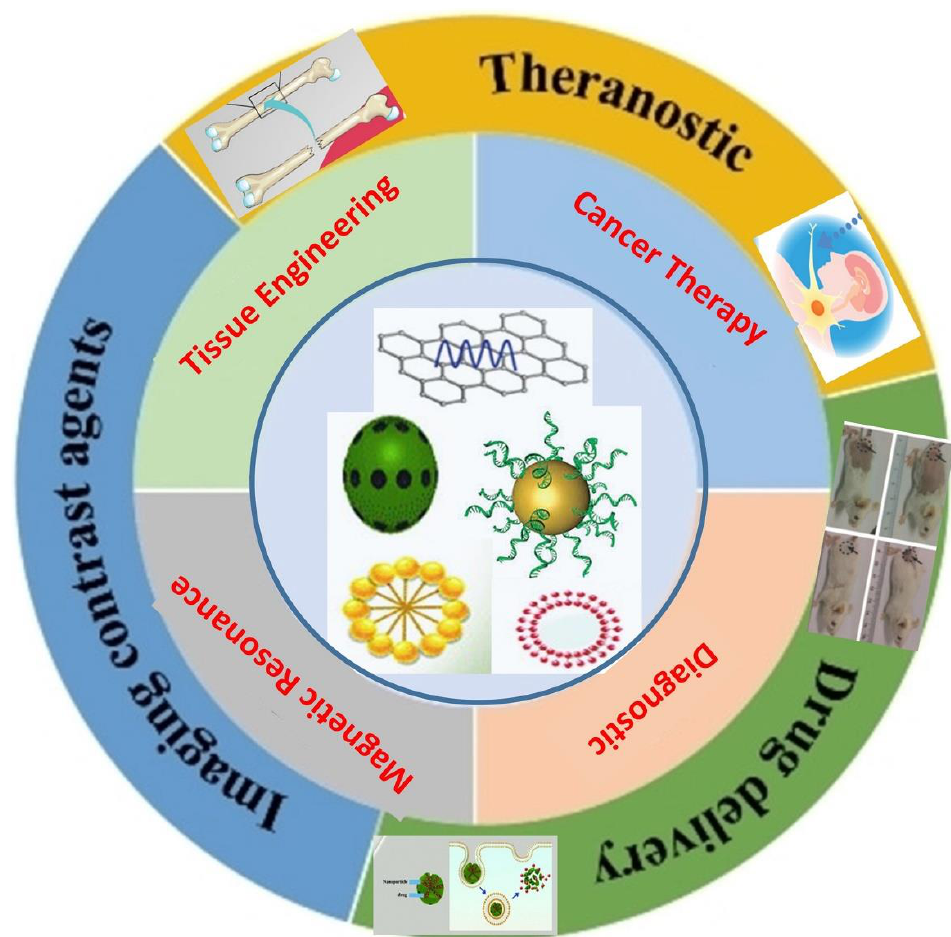
Figure 10. Schematic diagram for the utilization of graphene and its derivatives in the transport of drugs and genetic material. Reprinted with permission from Ref. [143].